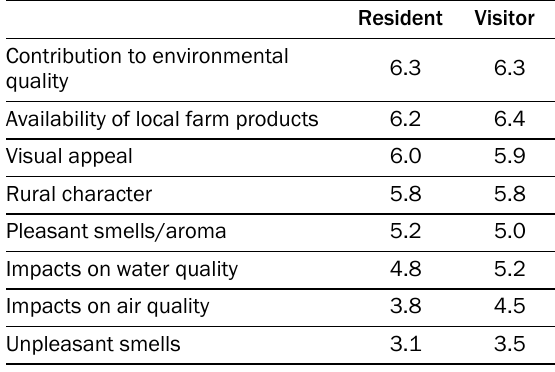
Table 8. Importance of Various Farmland Characteristics (1= not important, 7 = very important;